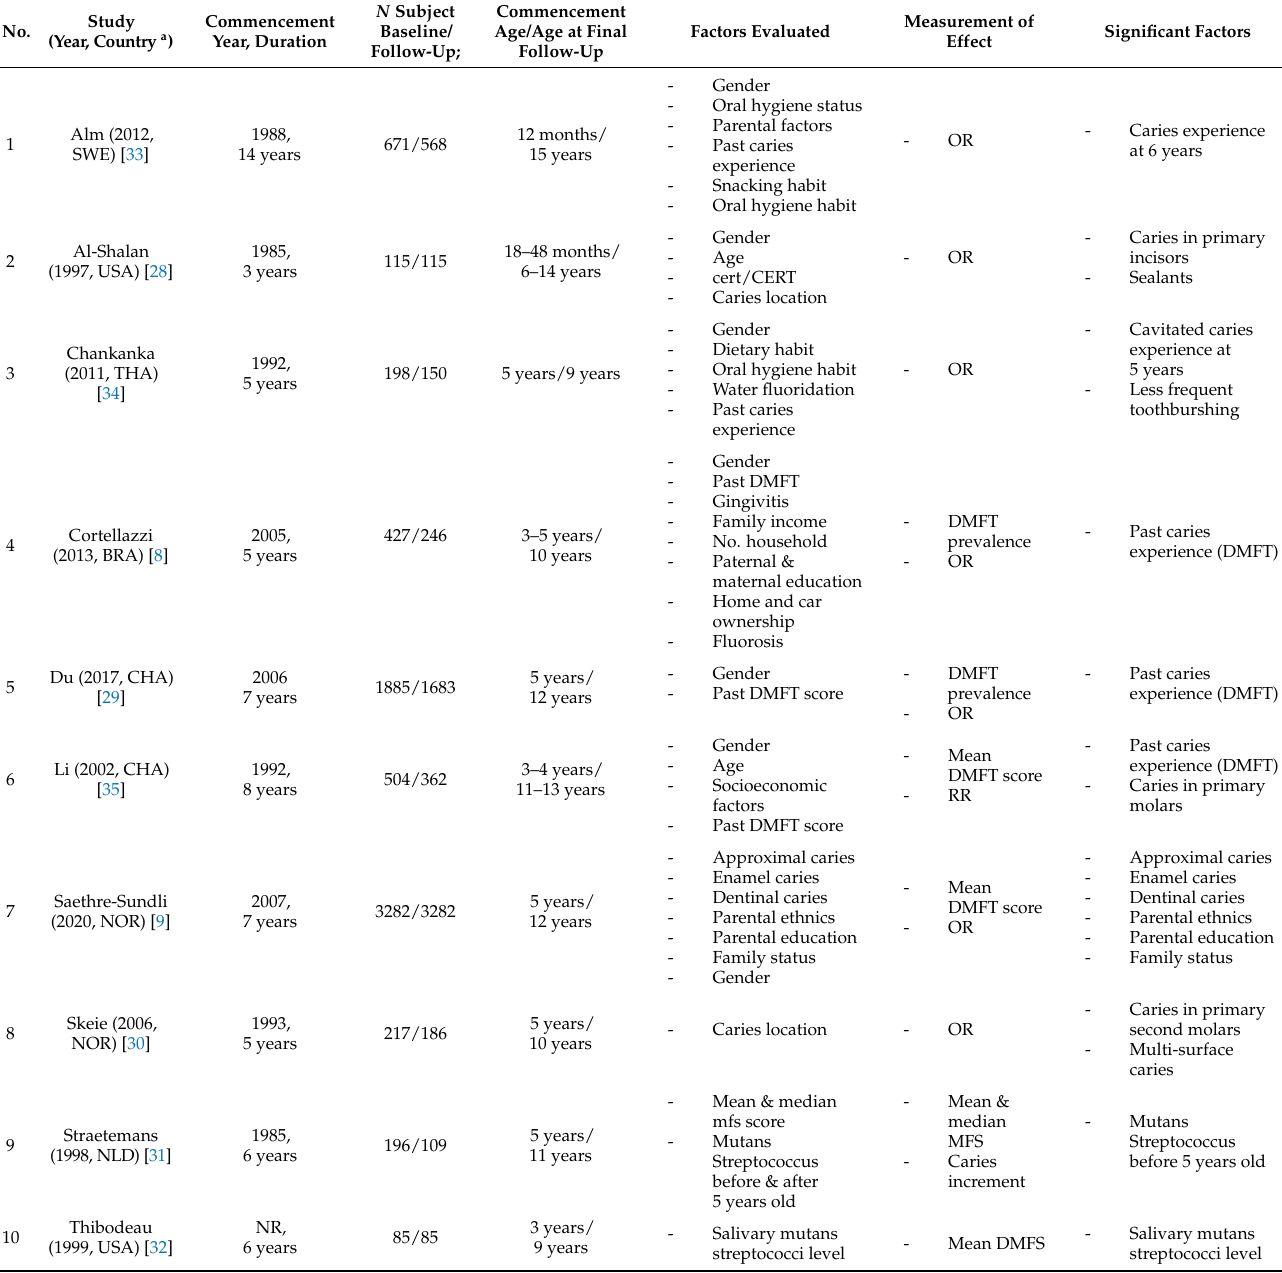
Table 1. Characteristics of included